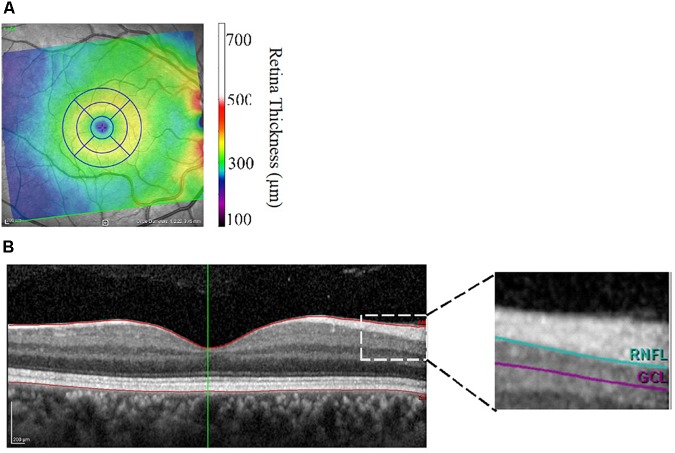
(A,B) Image output from Heidelberg Spectralis Optical Coherence Tomography focusing on the macula (A) and cross-sectional view of the retinal layers (B). Central foveal thickness was assessed at the foveal pit. RNFL, retinal nerve fiber layer; GCL, ganglion cell layer thickness.